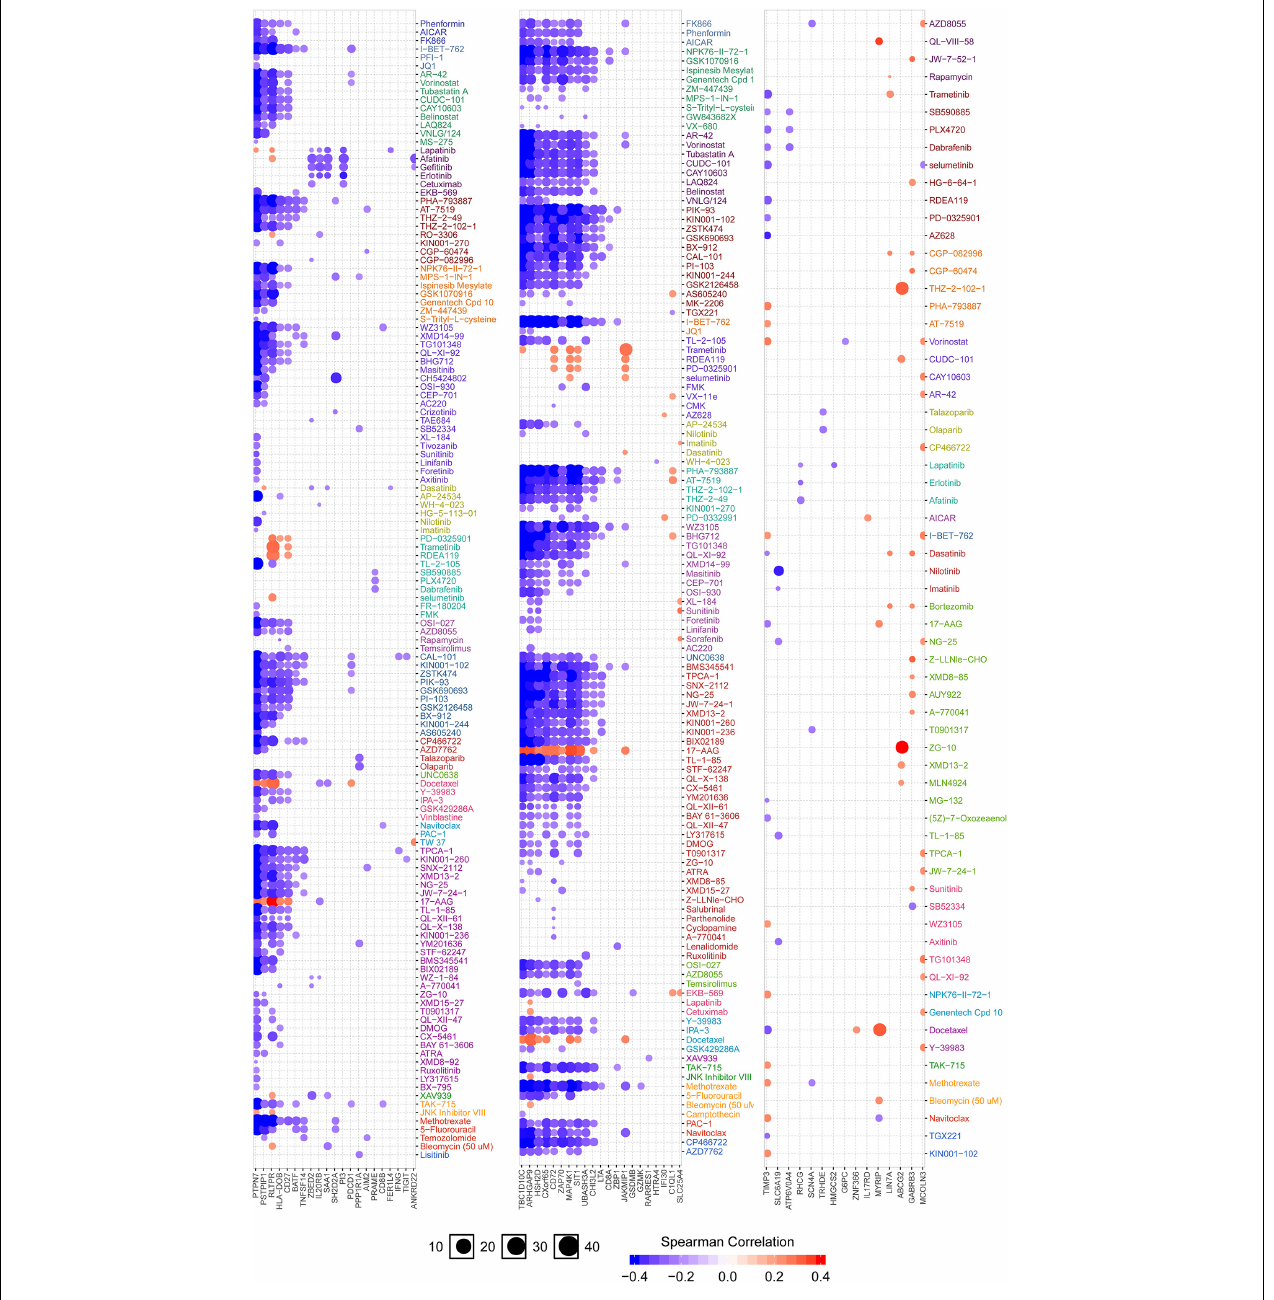
FIGURE 7 | Analysis of drug sensitivity associated with IGFLR1. Red is positive correlation, which means the higher the gene expression, the more sensitive to the drug, while the blue is the